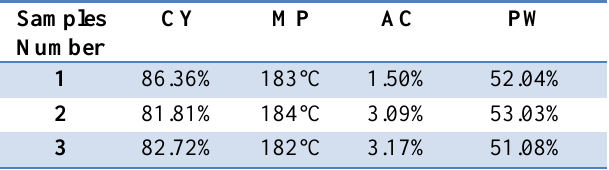
Table 1 : The Curcumin yield (CY), Melting point (MP), Ash Content (AC) and Percentage of Whiteness (PW) of the studied tumeric samples.